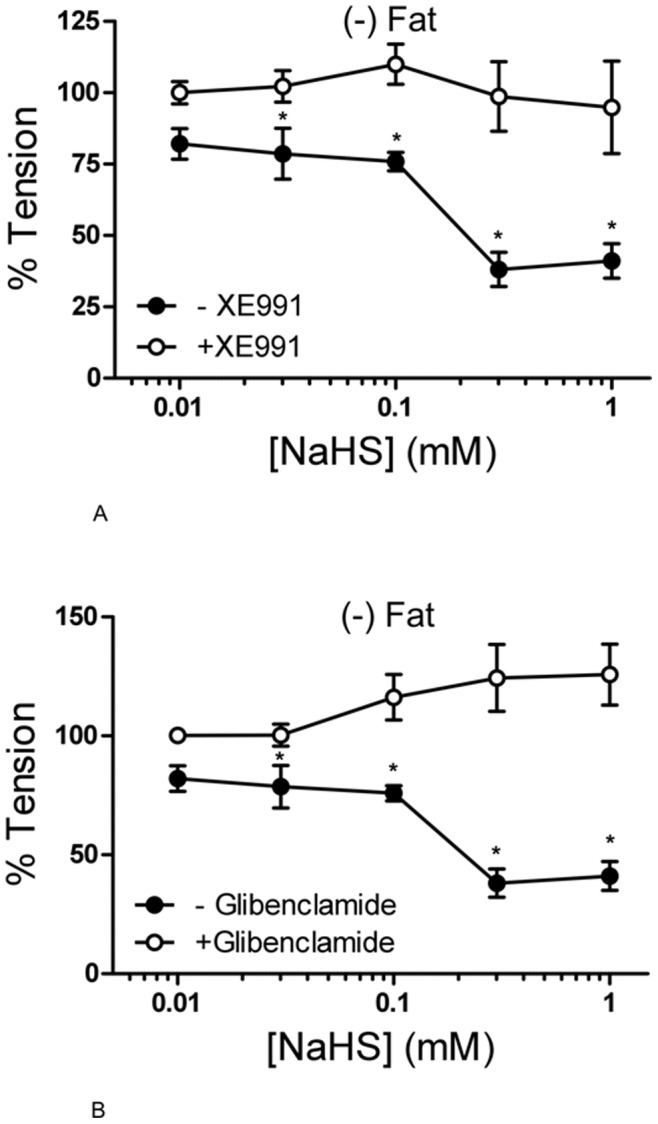
NaHS dose response curve of rat aortic rings without perivascular fat with and without preincubation with XE991 (15 min, 30 µmol/l) (panel A) or with and without preincubation with glibenclamide (15 min, 3 µmol/l) (panel B).Rat aortic rings were precontracted with 5-HT (2 µmol/l) and then stepwise relaxed with NaHS (0.01–1 mmol/l). * p<0,05. n = 9 in control groups. n = 6 in groups with XE991 and glibenclamide, respectively.